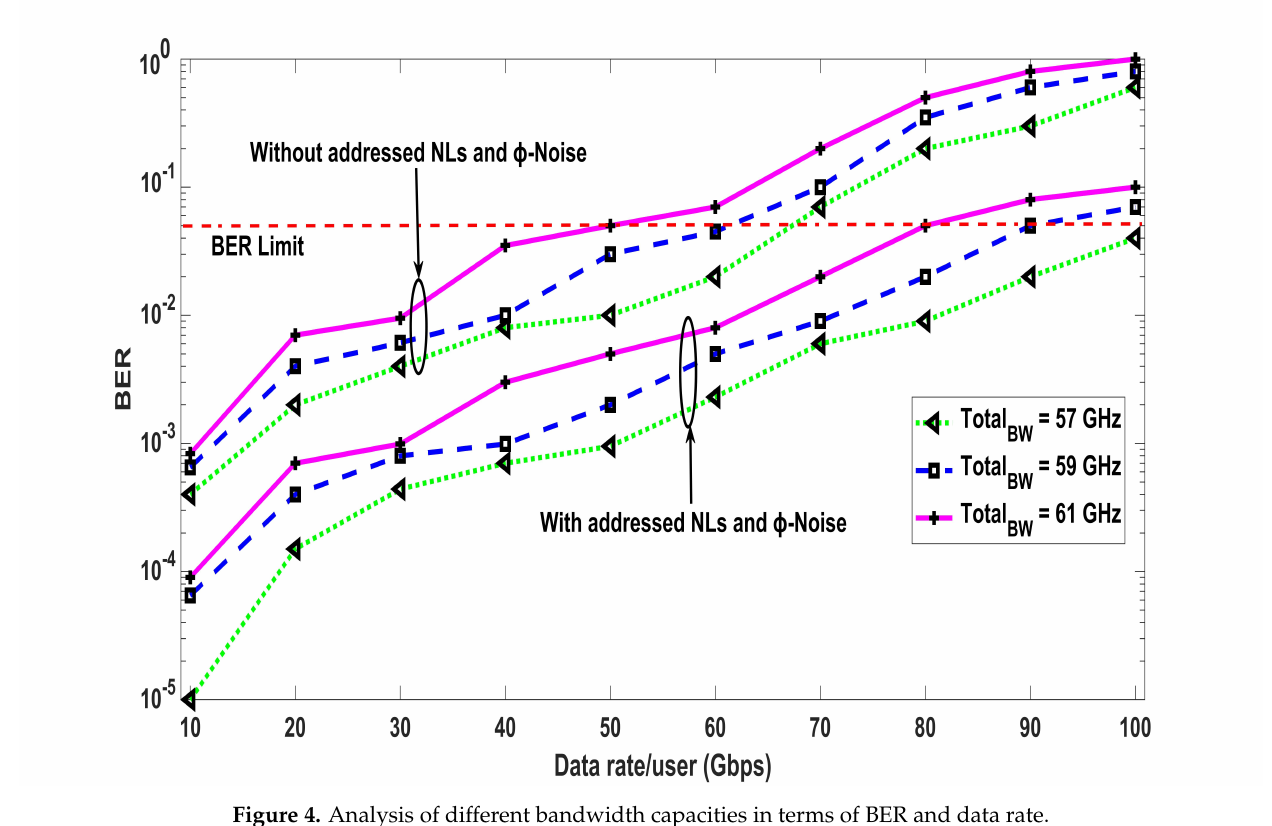
Figure 4. Analysis of different bandwidth capacities in terms of BER and data rate.